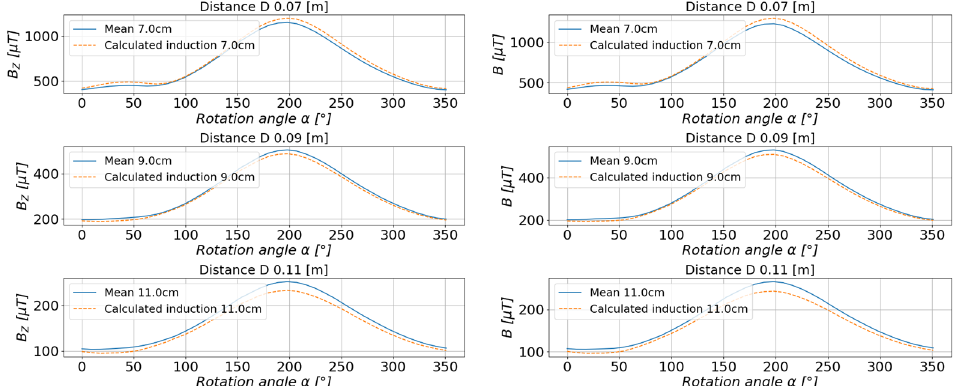
Figure 23. Comparison of the estimated values with the measured values of the magnetic induction in the measurement axis Z ( left ) and the resultant value of the scalar magnetic induction B ( right ). In order to assess the quality of the approximation, the value of the relative error was calculated, shown in Figure 24 in the form of a bar graph, for each control distance as a function of the base rotation angle.